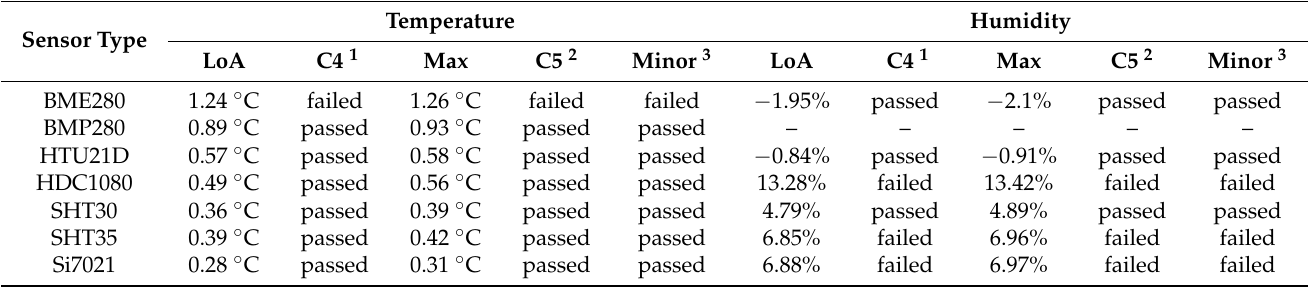
Table 10. Comparison of worst-case differences between data from temperature and humidity sensors and data from the reference weather